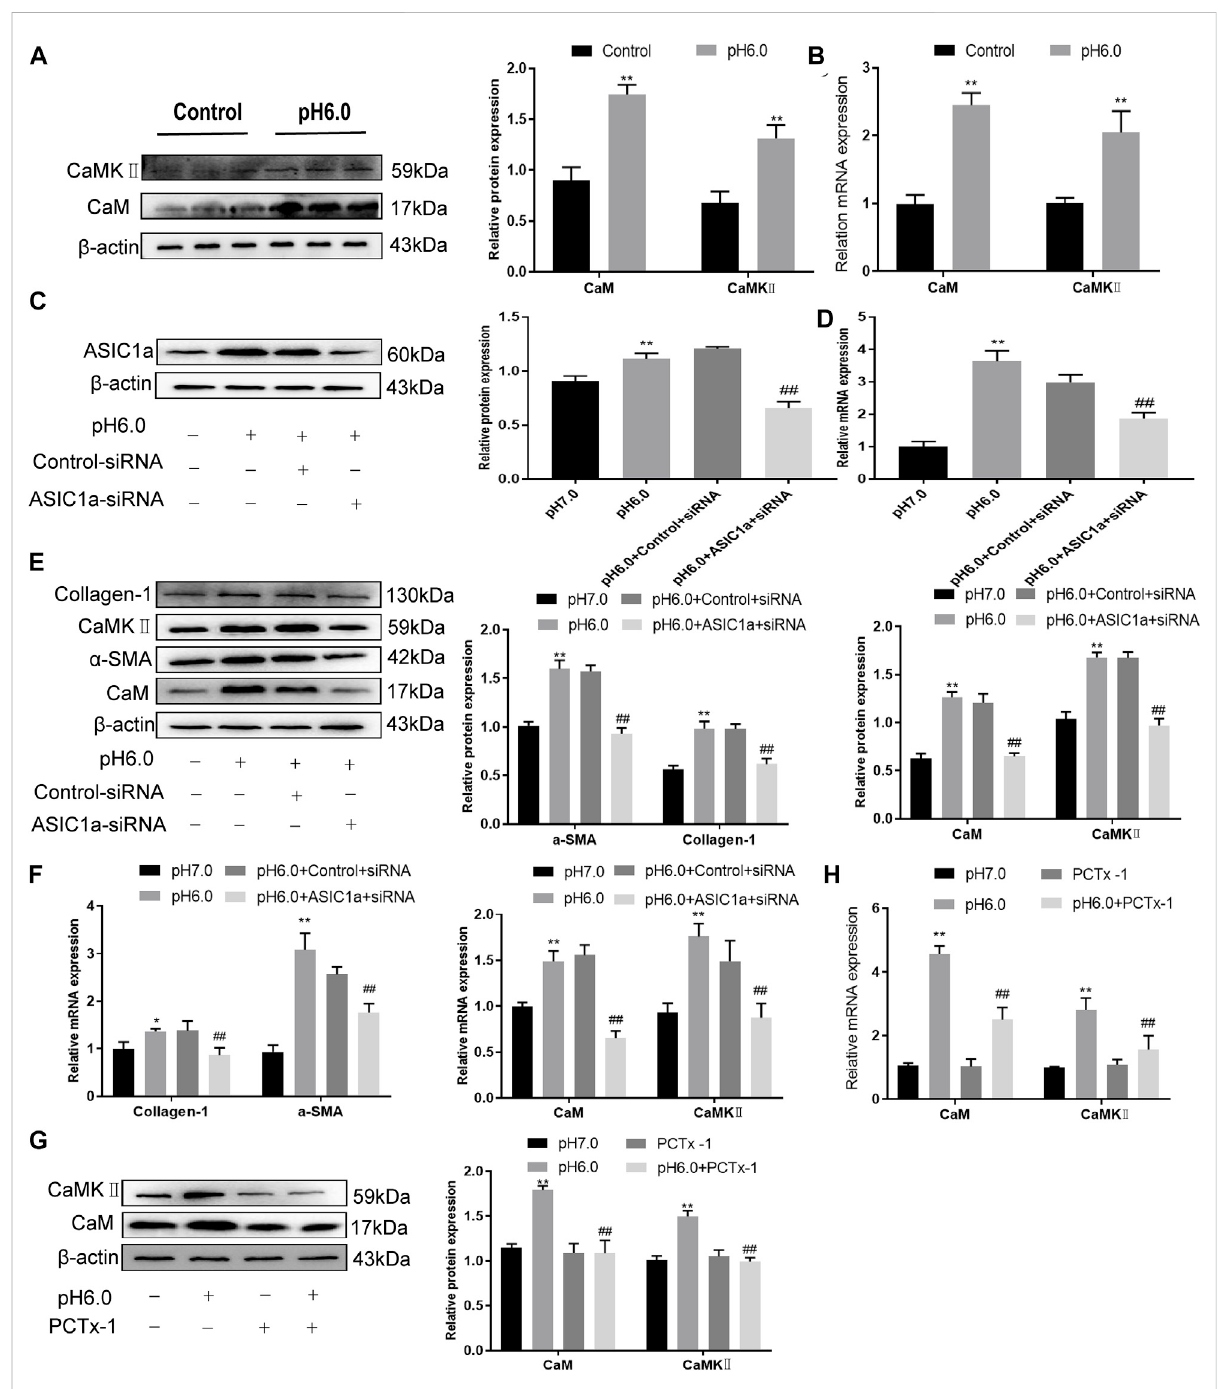
Effect of ASIC1a-siRNA transfection and PcTx-1 on ASIC1a, α -SMA, and collagen- Ι as well as CaM and CaMK Ⅱ expression in HSC-T6 cells. (A) WesternblottingwasusedtodetecttheexpressionofCaMandCaMK Ⅱ proteininHSCsstimulatedbypH6.0. (B) ThemRNAlevelsofCaMandCaMK Ⅱ in HSCs stimulated by pH 6.0 were detected by qRT-PCR. (C) ASIC1a protein level in HSCs was detected by Western blotting after silencing ASIC1a. (D) ASIC1a mRNA level was detected by qRT-PCR after silencing ASIC1a. (E) Expression of CaM, CaMKII and fi brosis protein in HSCs after silencing ASIC1a. (F) mRNA level of CaM, CaMKII, and fi broprotein in HSCs after silencing ASIC1a. (G) CaM and CaMK Ⅱ protein levels in HSCs treated with PcTx-1 were detected by Western blotting. (H) The mRNA levels of CaM and CaMK Ⅱ in HSCs treated with PcTx-1 were detected by qRT-PCR. Statistical analyses were performed using t -test. Data are expressed as the mean ± SD ( n ≥ 3). * p < .05, ** p < .01 vs. Control group; # p < .05, ## p < .01 vs. pH 6.0